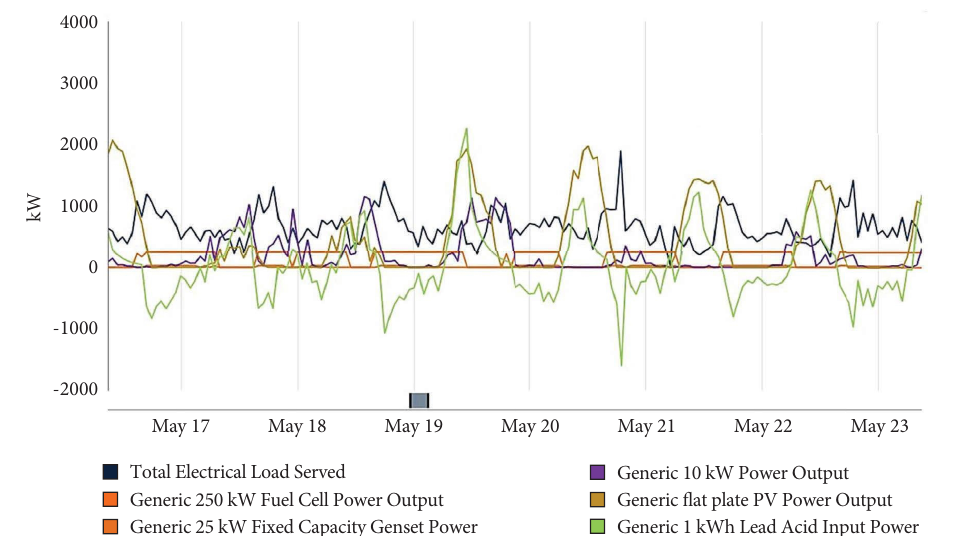
Figure 15: Hourly operation of electrical sources according to